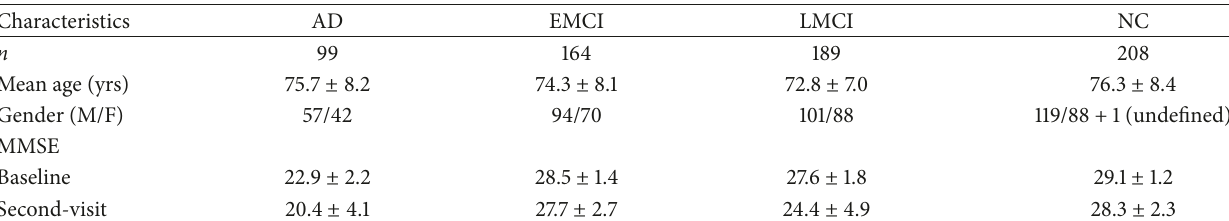
Figure 1: Overview of the proposed method. Table 1: Participant